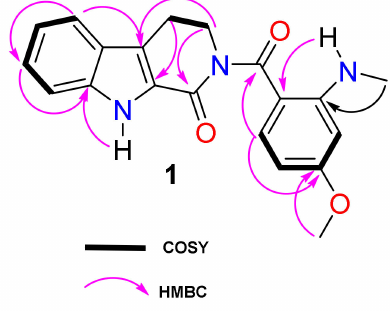
Figure 2. COSY and key HMBC correlations of compound 1